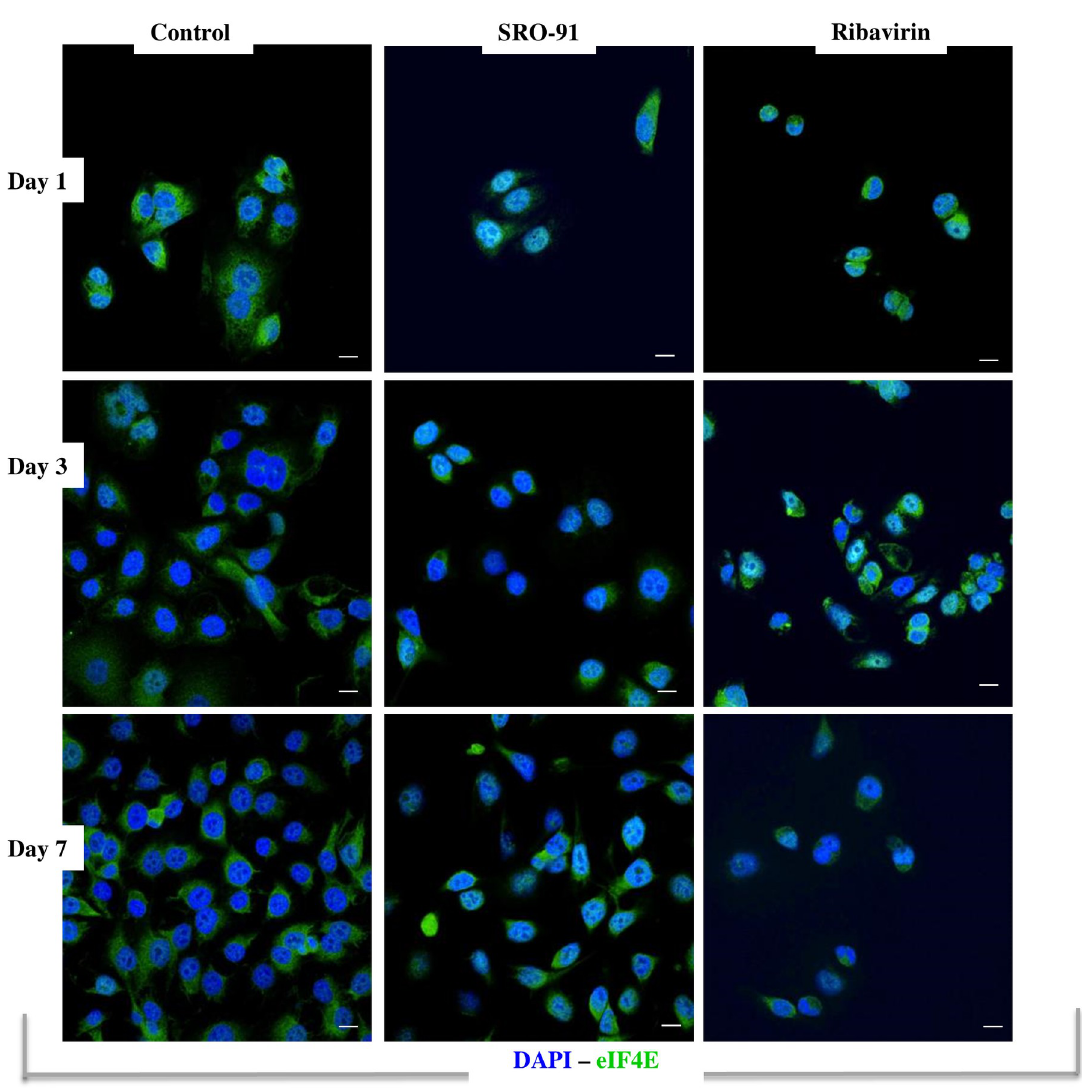
Fig 9. Localization of eIF4E in cancer cells under the effect of SRO-91. Immunofluorescent staining of eIF4E expressed by cancer cells after SRO-91 or ribavirin treatment or without treatment (control) during 7 days of culture. Cell nuclei were stained with DAPI. Staining was examined with laser scanning confocal microscopy. Scale bar is 30 μ